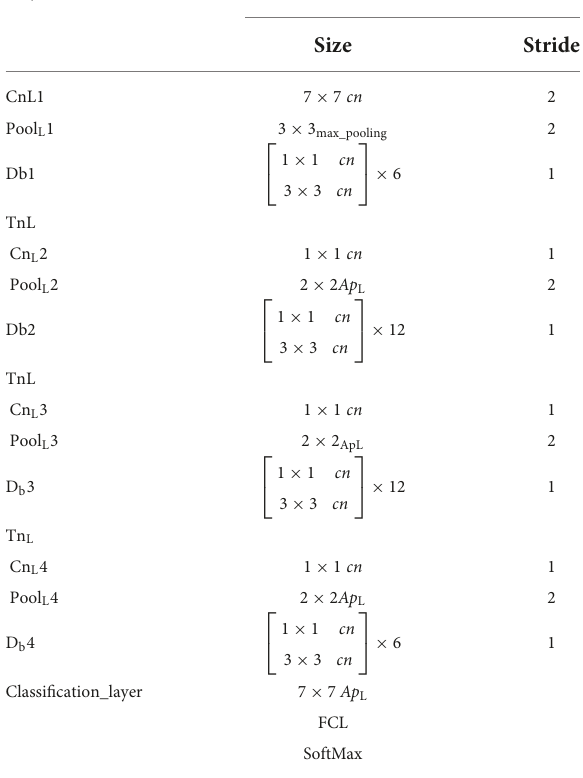
TABLE 2 Description of the DenseNet-77.